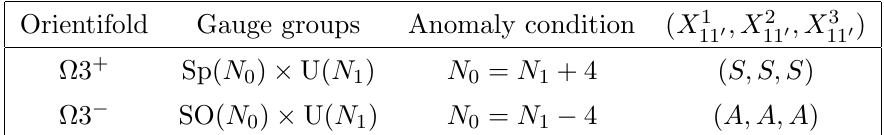
are projected onto symmetric 11 0